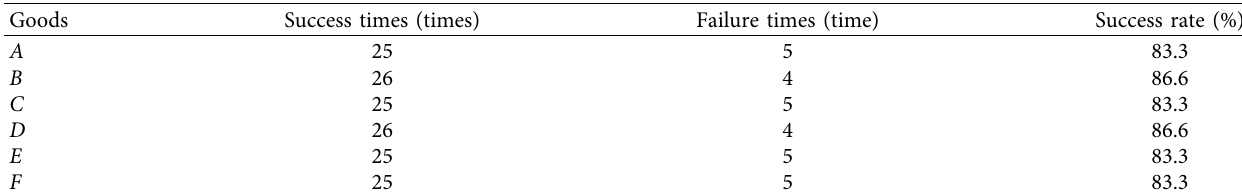
Table 4: Te experimental results of the static grabbing using the method in literature